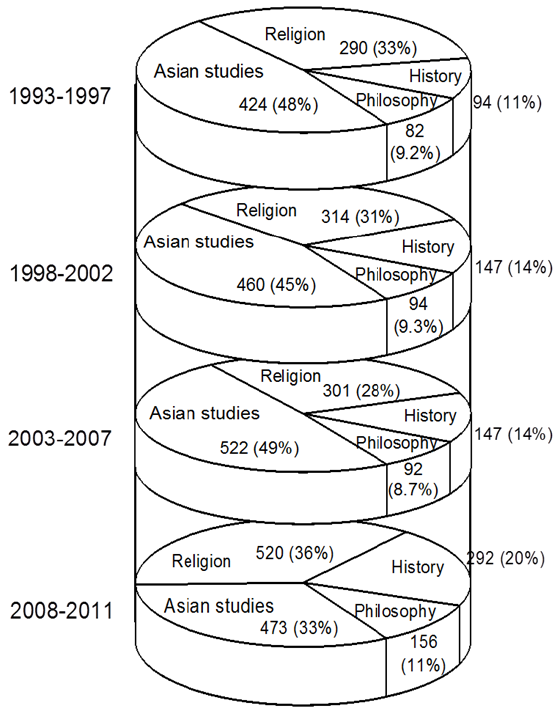
Figure 1. Distribution of the scholarly communications in the top four categories (Asian studies, Religion, Philosophy, and History) for four time windows in the range of years 1993–1997, 1998–2002, 2003–2007, and